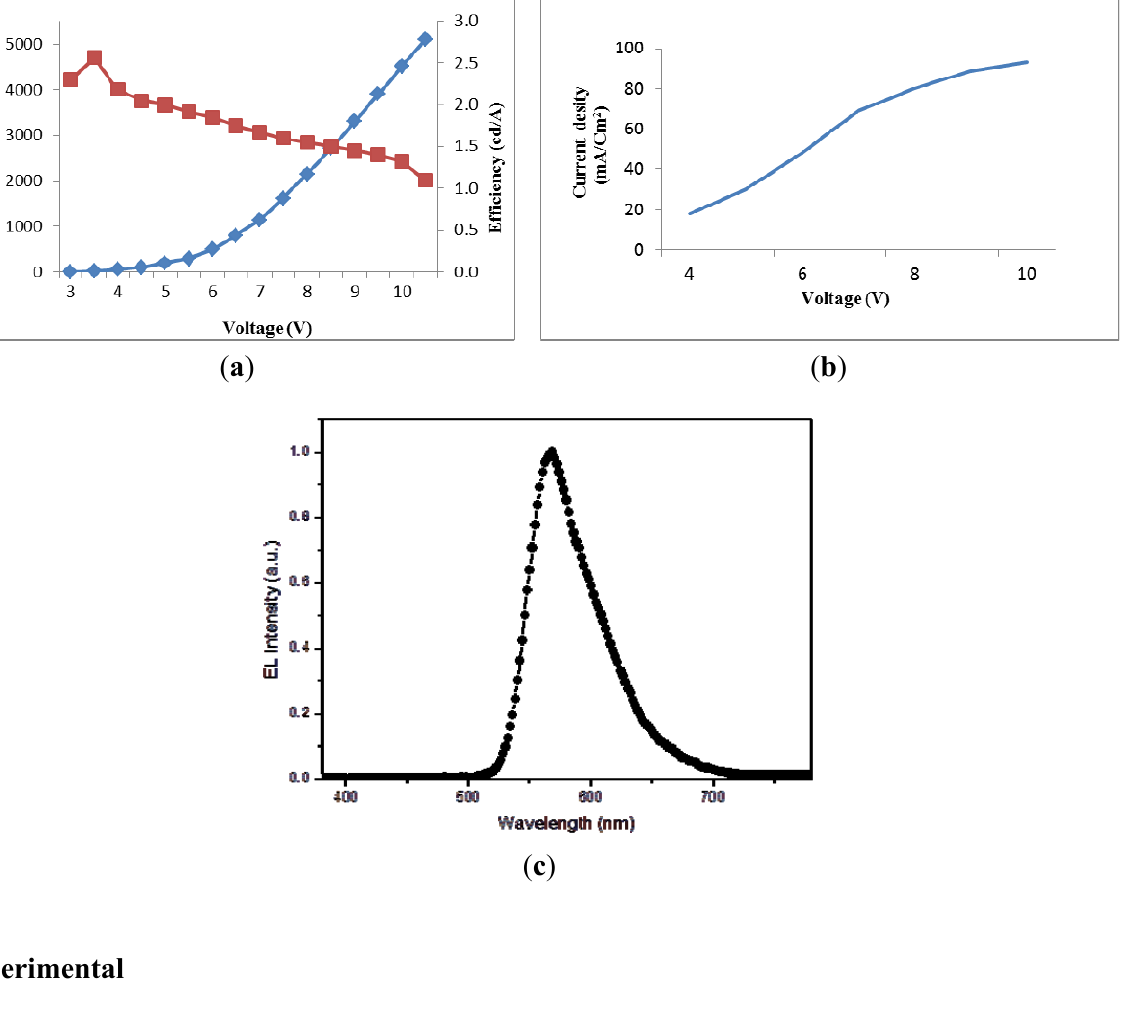
Figure 4. Device characteristics of the OLED with the configuration of